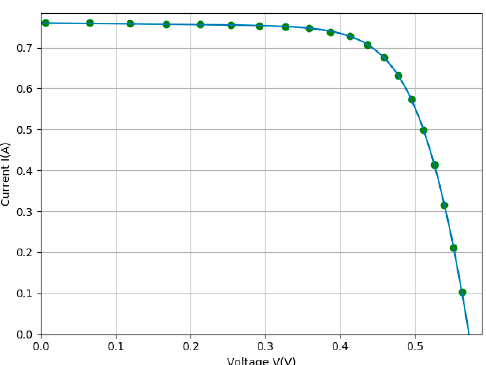
Figure 4. The evolution of average population fitness throughout the 100 iterations.